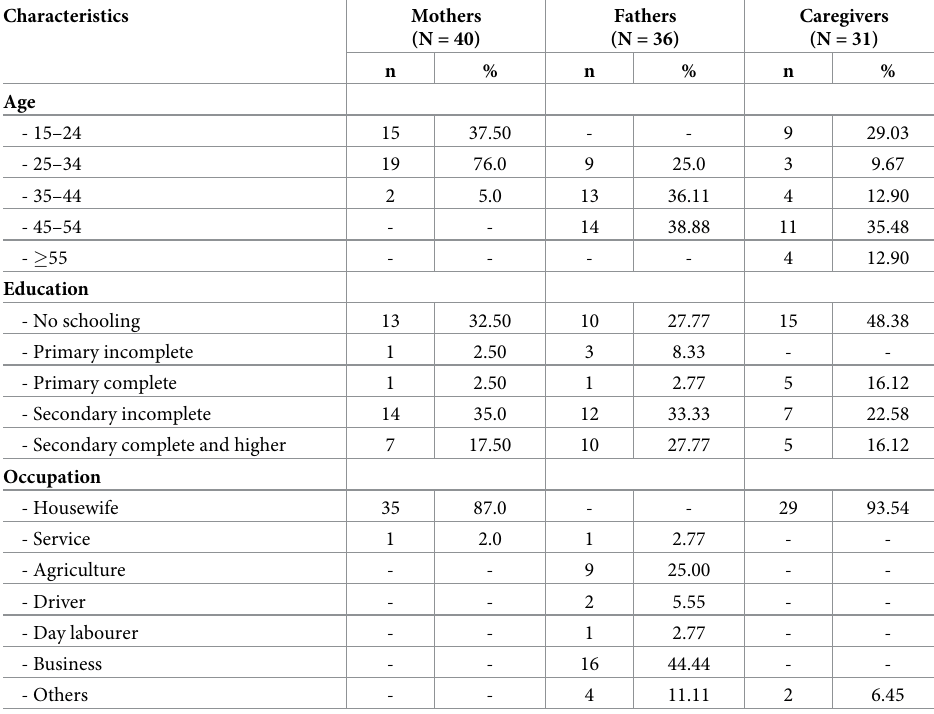
Table 2. Demographic characteristics of mothers, fathers and caregivers.